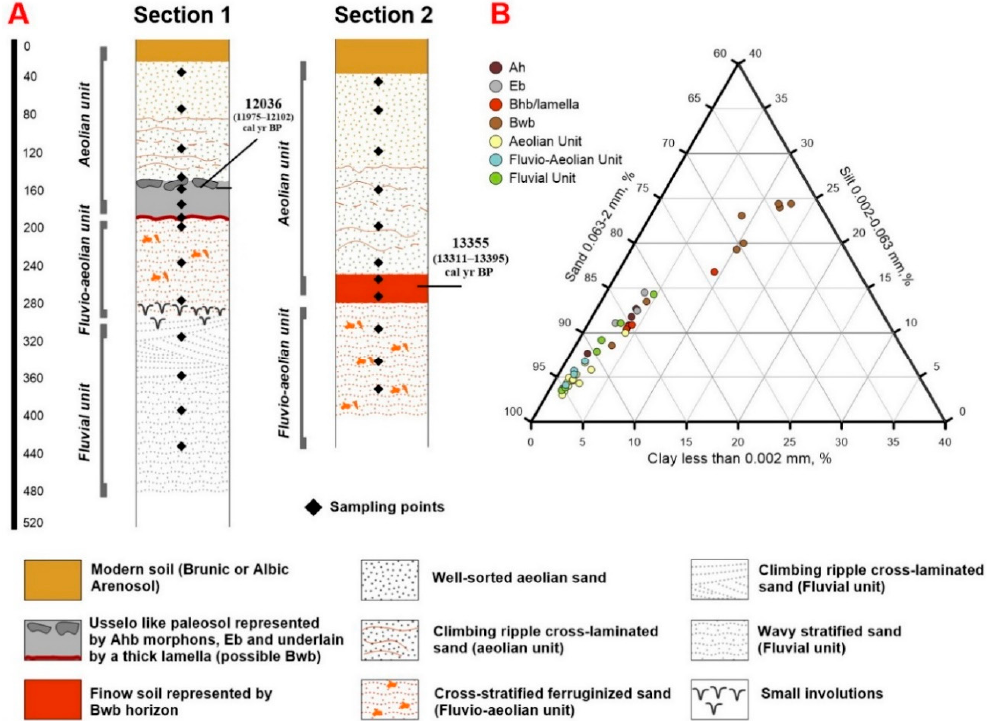
Figure 3. Stratigraphic and sedimentological characteristics of a fluvio-aeolian succession: ( A ) scheme showing stratigraphic position of paleosols in studied sections; ( B ) ternary diagram illustrating textural variability of studied sediments and paleosols.